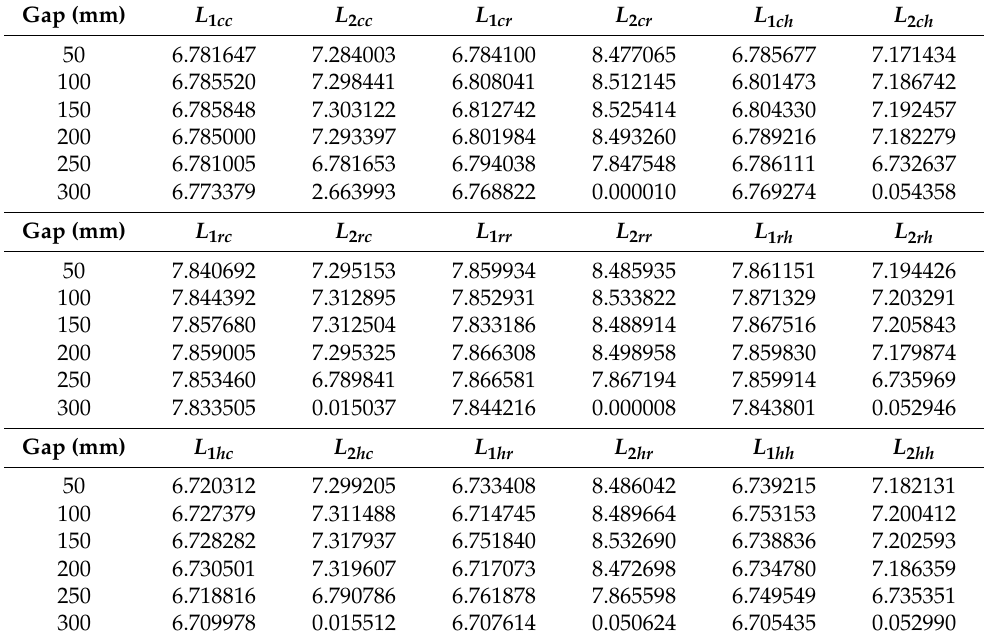
Table 15. The simulation results of transmitting and receiving coil inductance for the nine